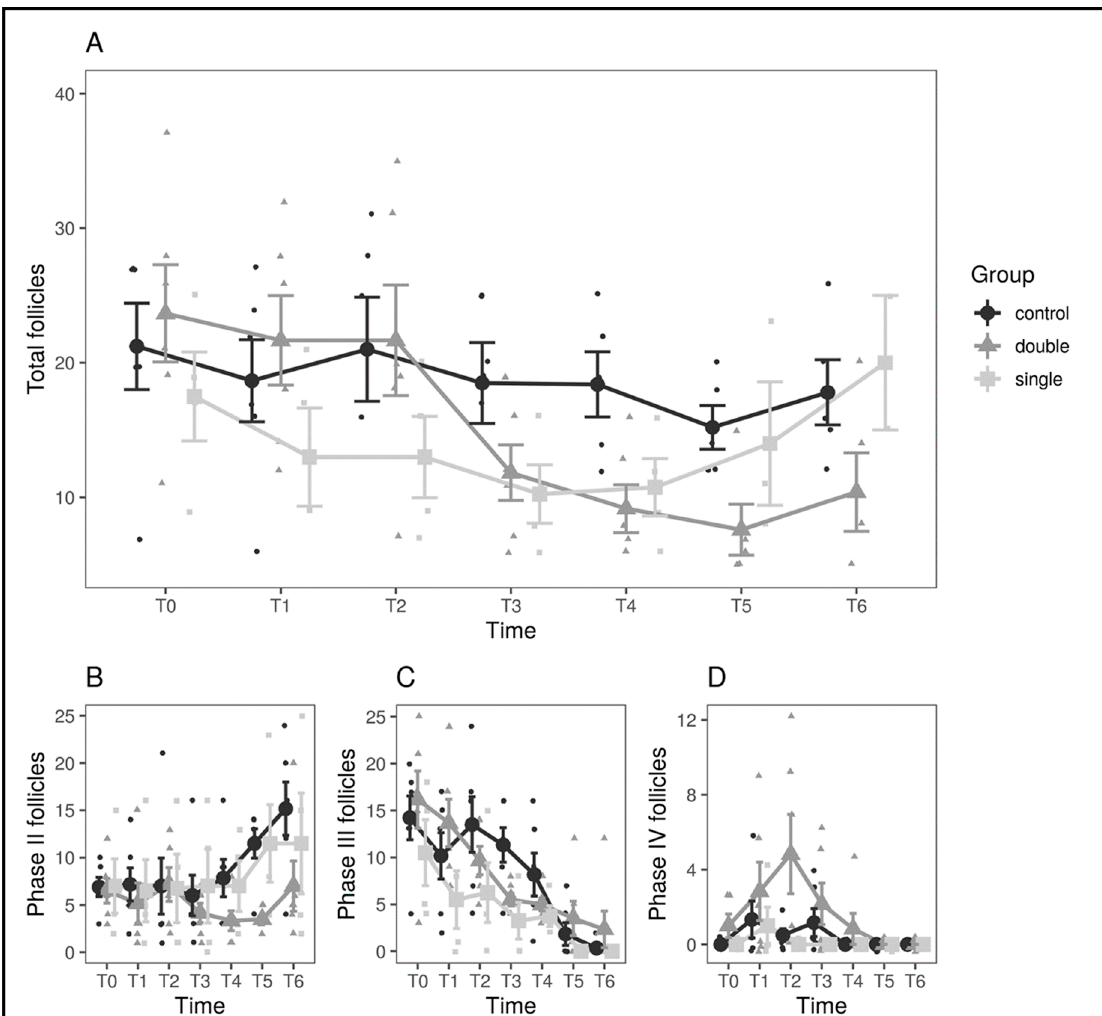
Figure 2. Comparison of the number of follicles between experimental groups and across timepoints. ( A ) Comparison between the control (black), single-implant (light gray), and double-implant (dark gray) groups. ( B – D ) Comparison between the three experimental groups for follicles in phases II ( B ), III ( C ), and IV ( D ) separately. In all panels, large dots represent means by group and timepoint, and vertical bars represent standard errors. Table 1. Mean, standard deviation (SD), and median values for total numbers of follicles (stages II to IV) and for stages